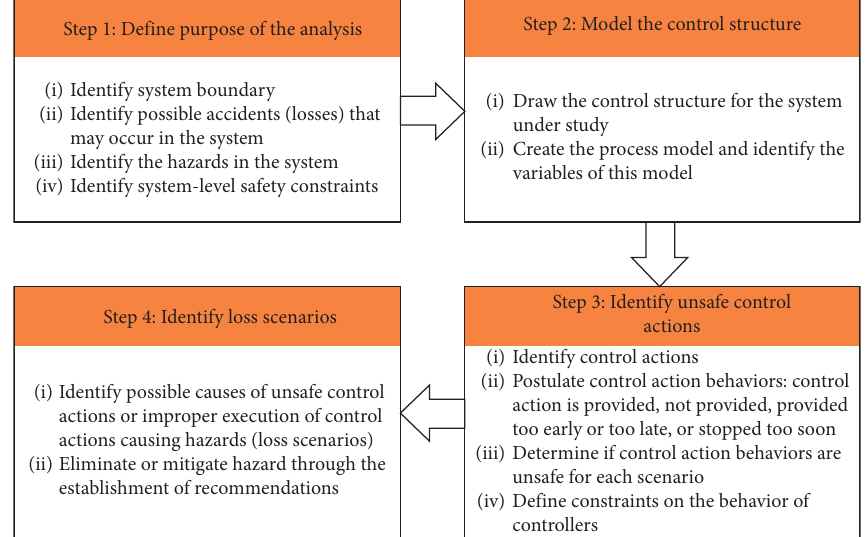
Figure 3: STAMP and STPA